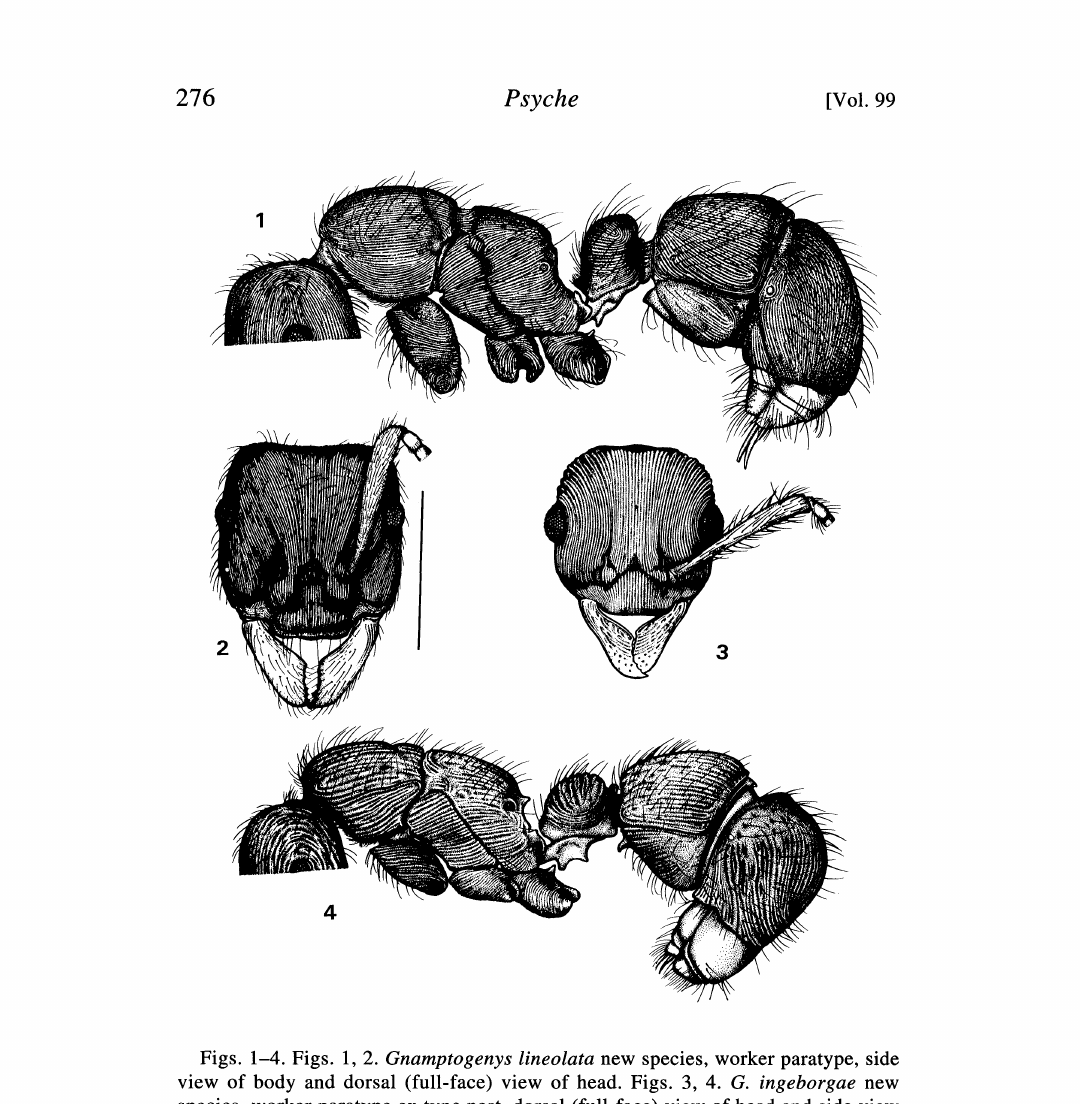
Figs. 1-4. Figs. 1, 2. Gnamptogenys lineolata new species, worker paratype, side view of body and dorsal (full-face) view of head. Figs. 3, 4. G. ingeborgae new species, worker paratype ex type nest, dorsal (full-face) view of head and side view of body. Scale line equals 1.0 mm. Drawings by Amy Trabka and the